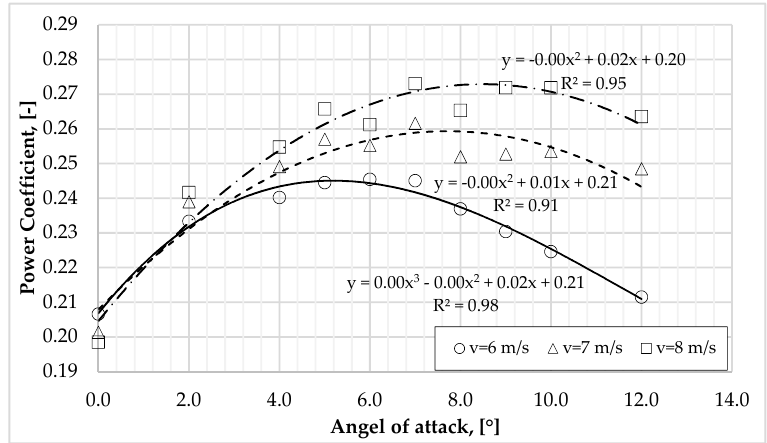
Figure 6. Power coefficient values based on the angle of attack at different airspeeds for air duct-free Figure 6. Power coe ffi cient values based on the angle of attack at di ff erent airspeeds for air duct-free blade design. blade design.